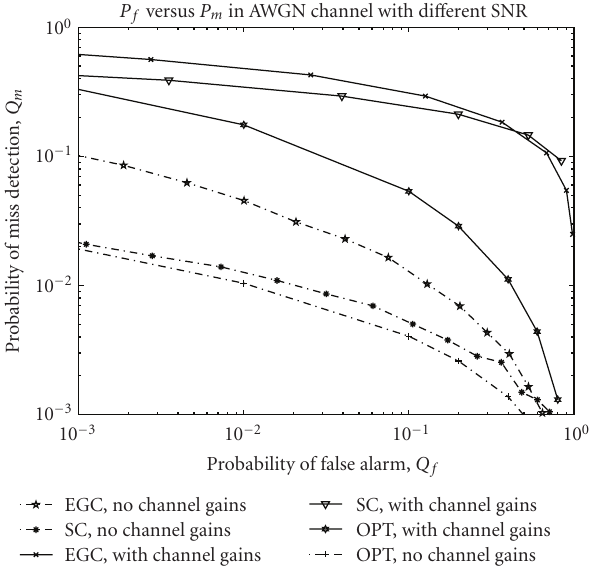
Figure 16: Receiver operating characteristics for collaborative spectrum sensing for 6 users in AWGN channel with im-perfect reporting channels, N = 10 .